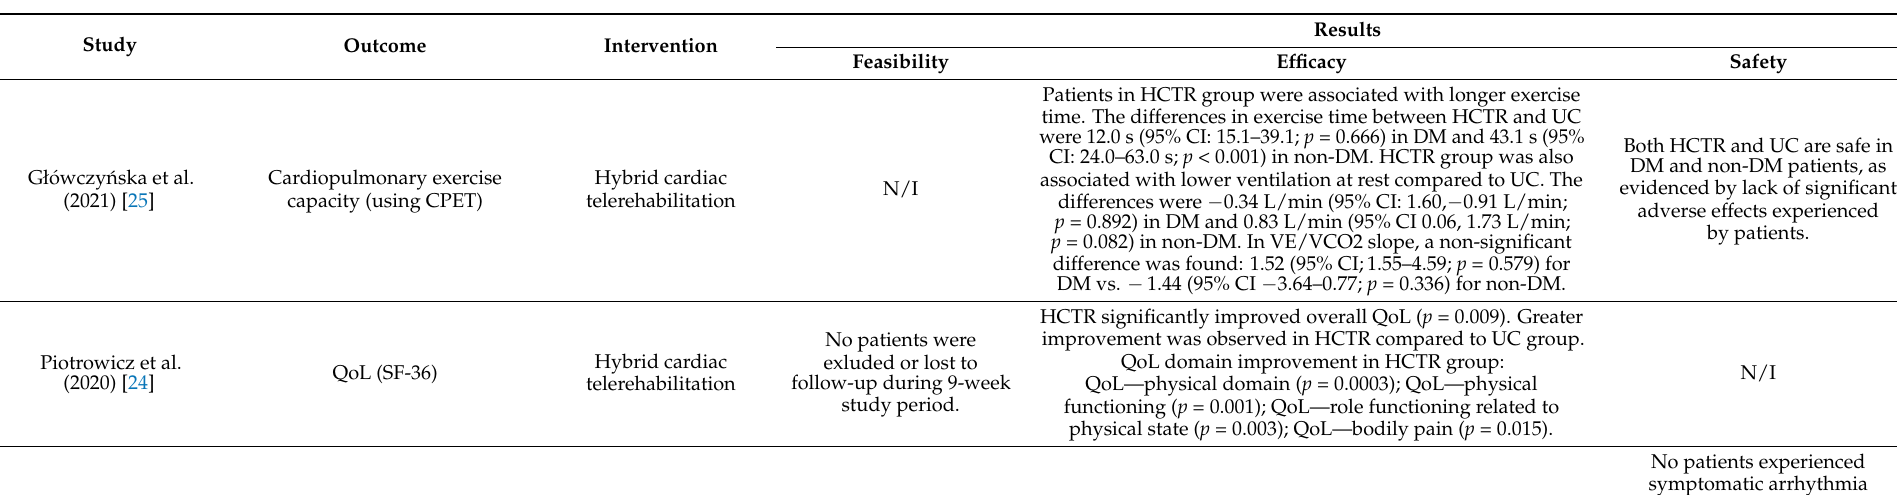
Table 3. Outcome